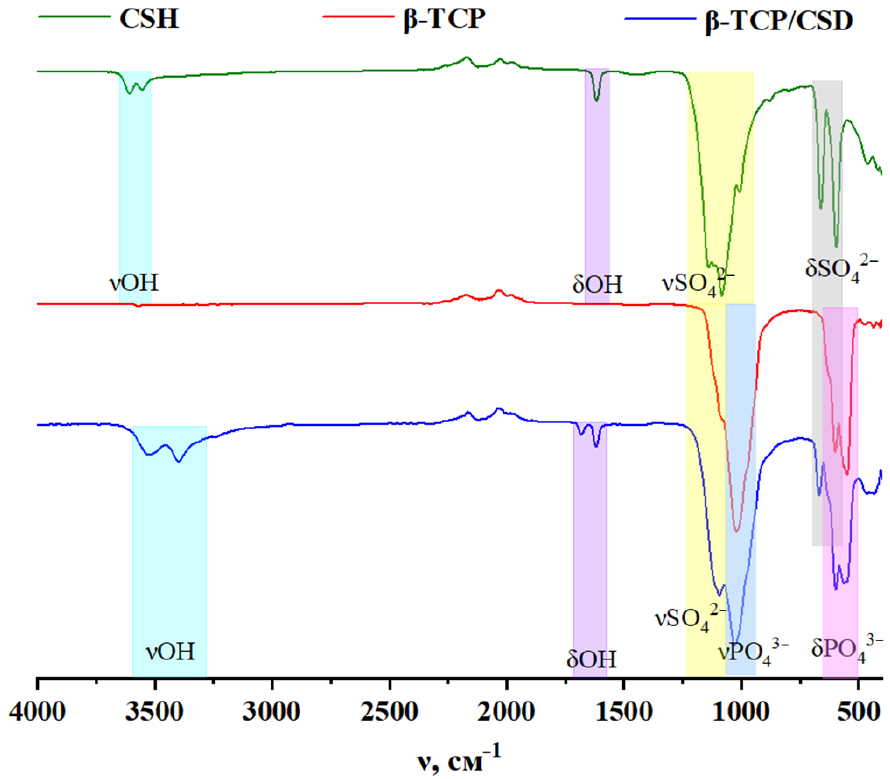
Figure 4. IR spectrum of CSH, β -TCP, and β -TCP/CSD water cement. In the IR spectrum of β -TCP/CSD, there is a slight shift of the bands of valence vibra- tions of the νPO 4 3− groups to a longer wavelength region due to the formation of a new phase on phosphate particles and anion geometry distortion as a result of nonsymmetric interactions in the crystal. Specific absorption bands are also observed at 3400 cm −1 and 1620 cm −1 , which are related to the adsorbed water (bound OH-group), its valence, and deformation vibrations, respectively. The band at 3527 cm −1 appears because of the va- lence vibrations of OH-ions of the crystallohydrate lattice (free OH-group) [30]. The sulfate ion can be identified by valence and deformation vibrations in the range of 980 – 1100 cm −1 and 550 – 650 cm −1 , respectively [52]. In the case of CaSO 4 ·1/2H 2 O, there are fluctuations in the sulfate and hydroxide ions of the lattice, as shown in Figure 4. The IR spectra of the composites (Figure 5) differ by the small shifts of the sulfate group band, which may be related to anion geometry distortion, inductive, and me- someric effects as a result of the interaction with polymeric chains.